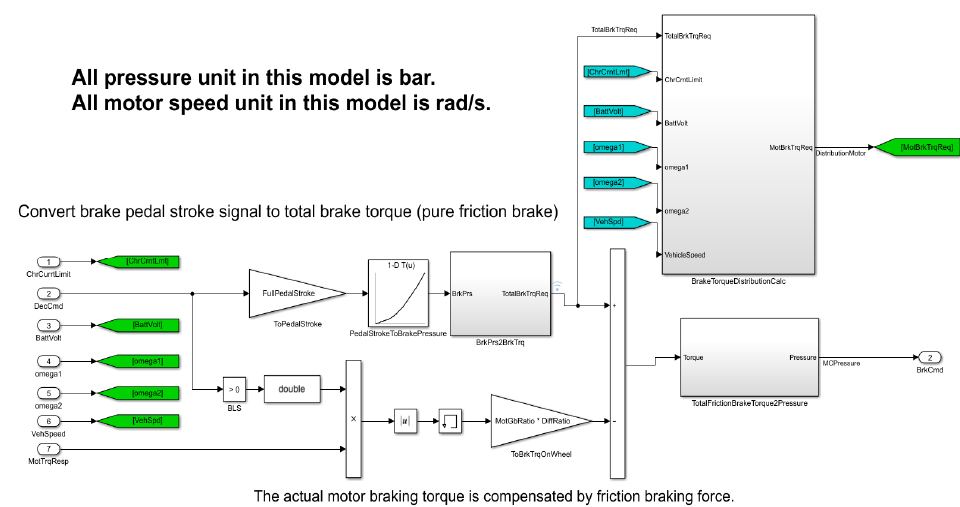
Figure 4. The Simulink model for the regenerative brake system.